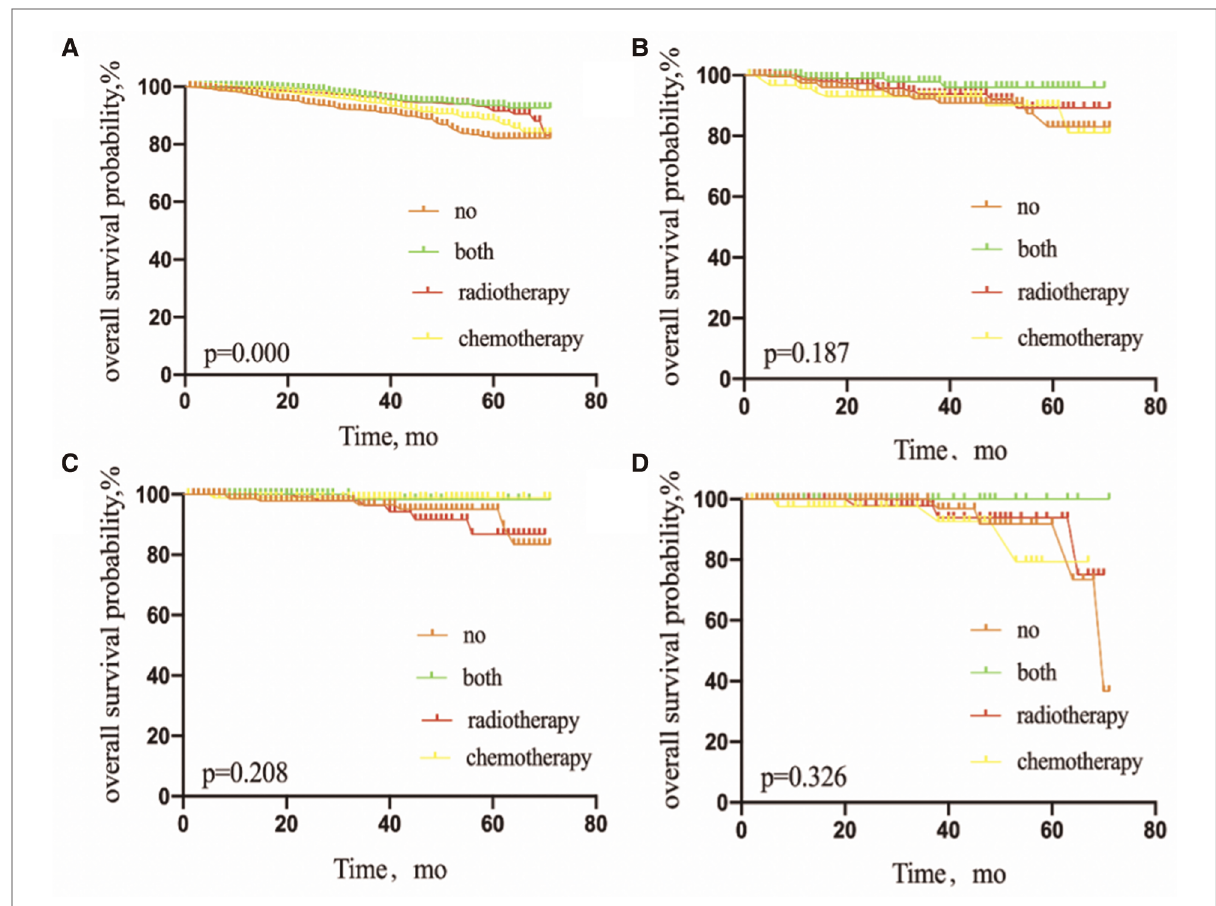
FIGURE 3 Kaplan – Meier curves depicting overall survival between treatment arms in patients with IDC ( A ), invasive lobular carcinoma ( B ), invasive ductal and lobular carcinoma ( C ), or IDC mixed with other types of carcinoma ( D ) with 1 or 2 sentinel lymph node micrometastases treated with sentinel lymph node biopsy alone. IDC, invasive ductal carcinoma; NO patients treated with no adjuvant therapies; BOTH patients treated with both adjuvant chemotherapy and radiotherapy; RADIOTHERAPY patients treated with adjuvant radiotherapy; CHEMOTHERAPY patients treated with adjuvant